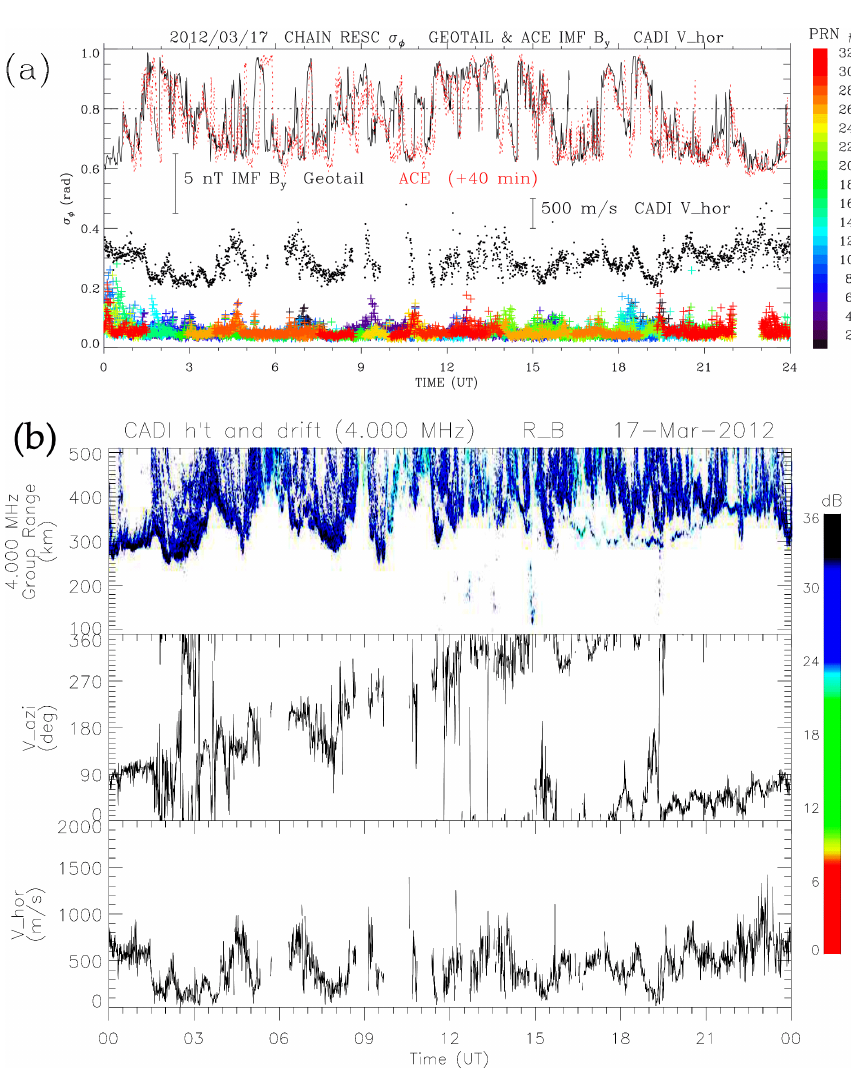
Figure 16. (a) The IMF B y (GSE) observed by ACE (shifted by 40min) and Geotail in front of the Earth’s bow shock. The RESC CADI horizontal drift velocity is superposed above the plot of phase scintillation index σ (cid:56) for the GPS receiver RESC at elevations above 30 ◦ . (b) Fixed frequency ionograms and drift measurements by CADI at Resolute